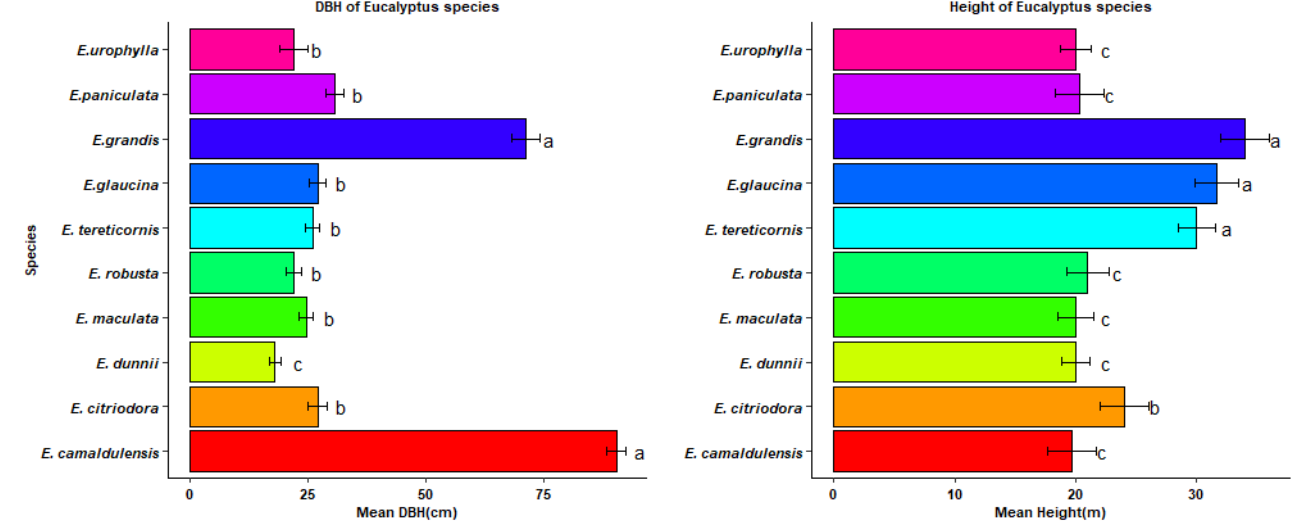
Figure 1. Mean and standard errors of DBH and Height of Eucalyptus species (same letters on the bars indicate that species means are not significantly different while different letters indicate significant differences in means at probabilty level of 0.05).